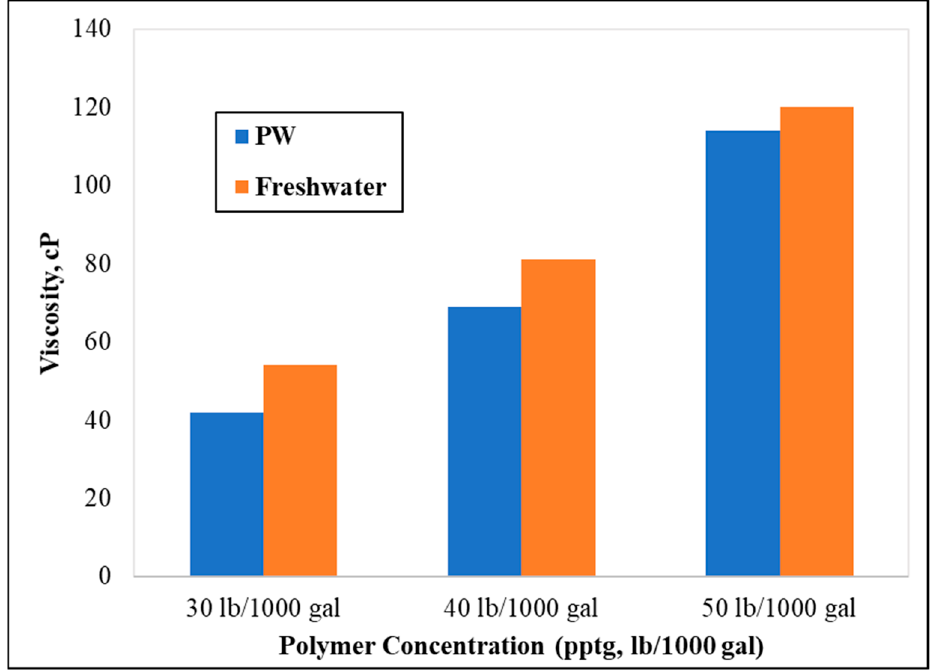
Figure 2. Viscosity measurements of CMHPG polymer in DI and PW (shear rate= 171 s − 1 , pH= 7, temperature= 77 °F).